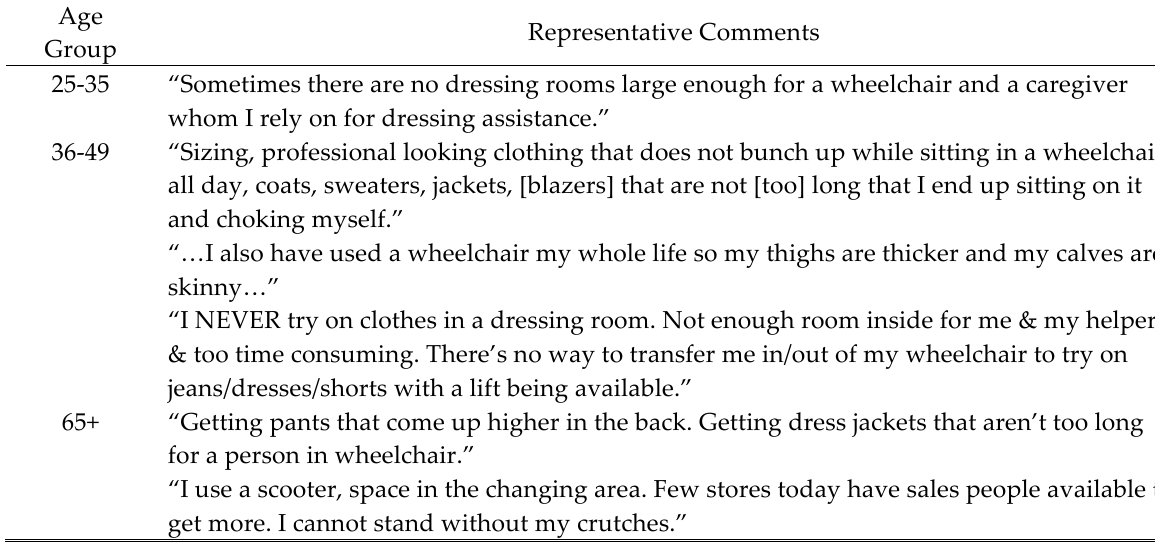
Table 5 . Representative Comments Regarding Wheelchair-Related Apparel and/or Dressing